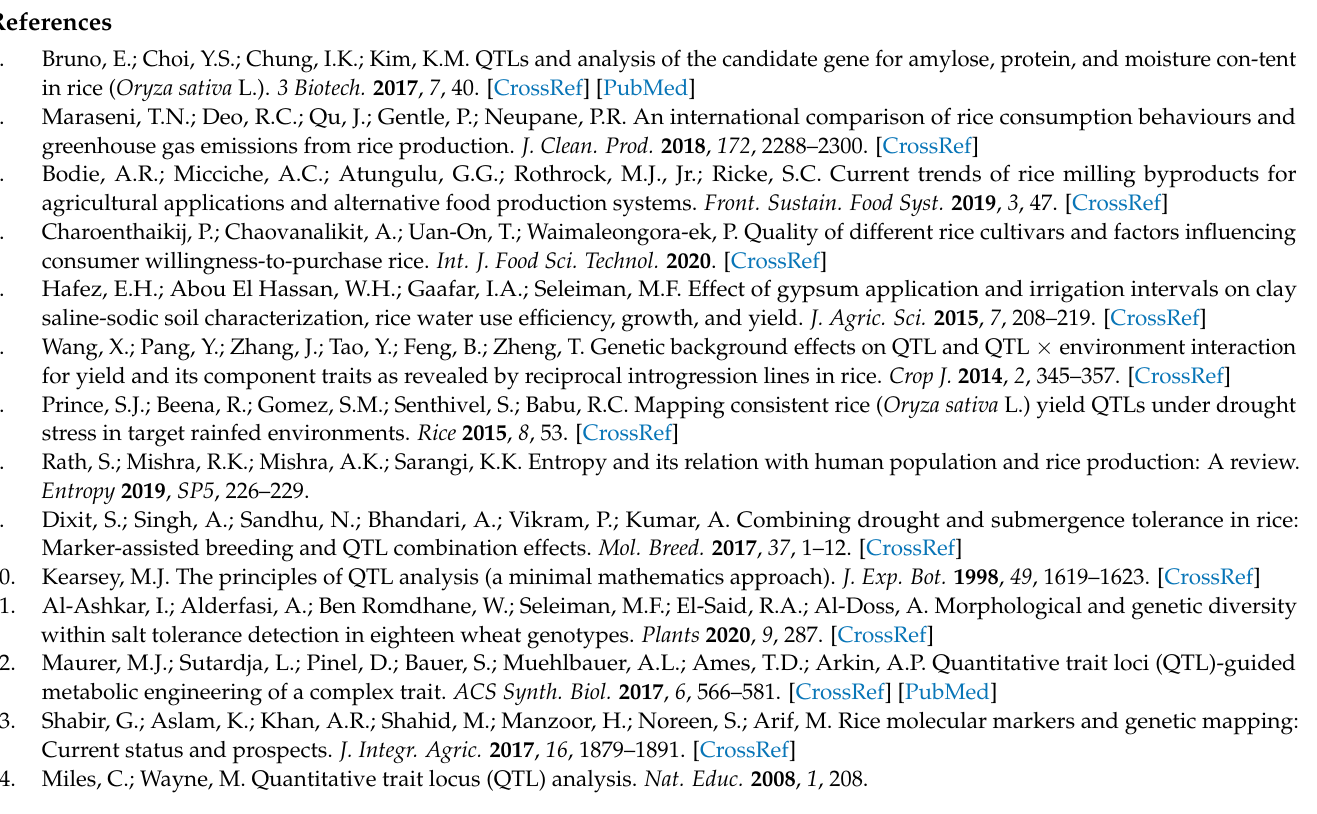
Supplementary Materials: The following are available online at https://www.mdpi.com/1422-0 067/22/5/2289/s1, Table S1: The grain length, grain width and 1000-grain weight from the 113 SNDH lines, Table S2: Analysis of correlation between grain length, grain width, and 1000-grain weight, Table S3: QTL related to the grain length, grain width, and 1000-grain weight in the Sam- gang/Nagdong DH population, Table S4: Candidate genes related to grain length, grain width, and 1000 grain